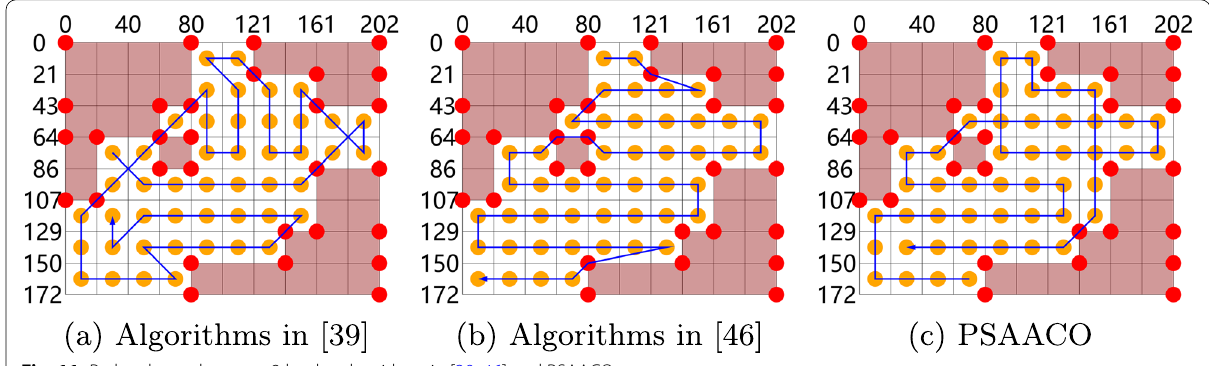
Fig. 11 Paths planned on area 2 by the algorithms in [39, 46] and PSAACO